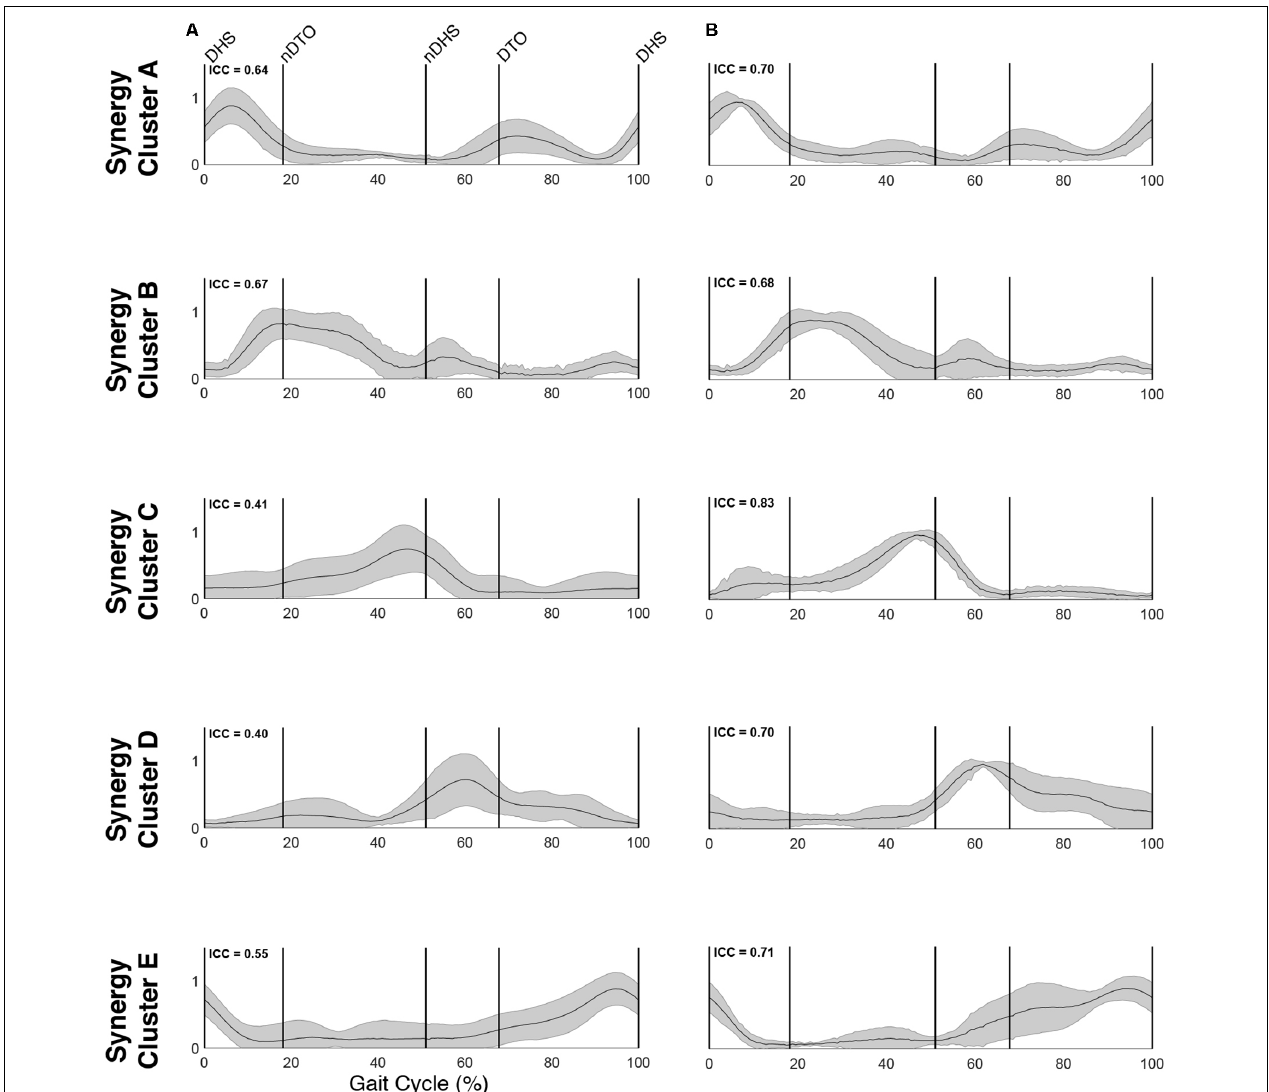
FIGURE 3 | Muscle synergy activations. Mean (standard deviation) activation profiles for each synergy cluster in (A) TD and (B) CP. Mean intraclass correlation coefficients (ICC) are reported in the upper left corner of each